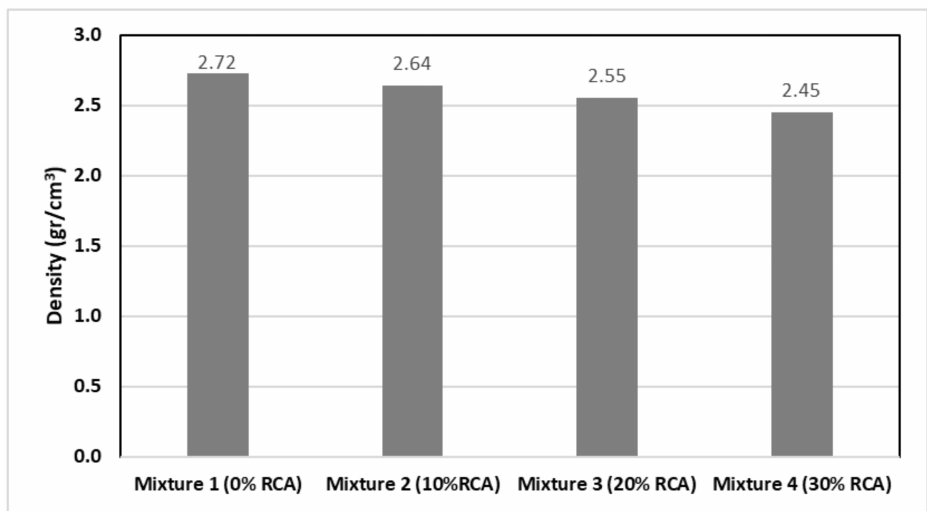
Figure 4. Density of the mixtures